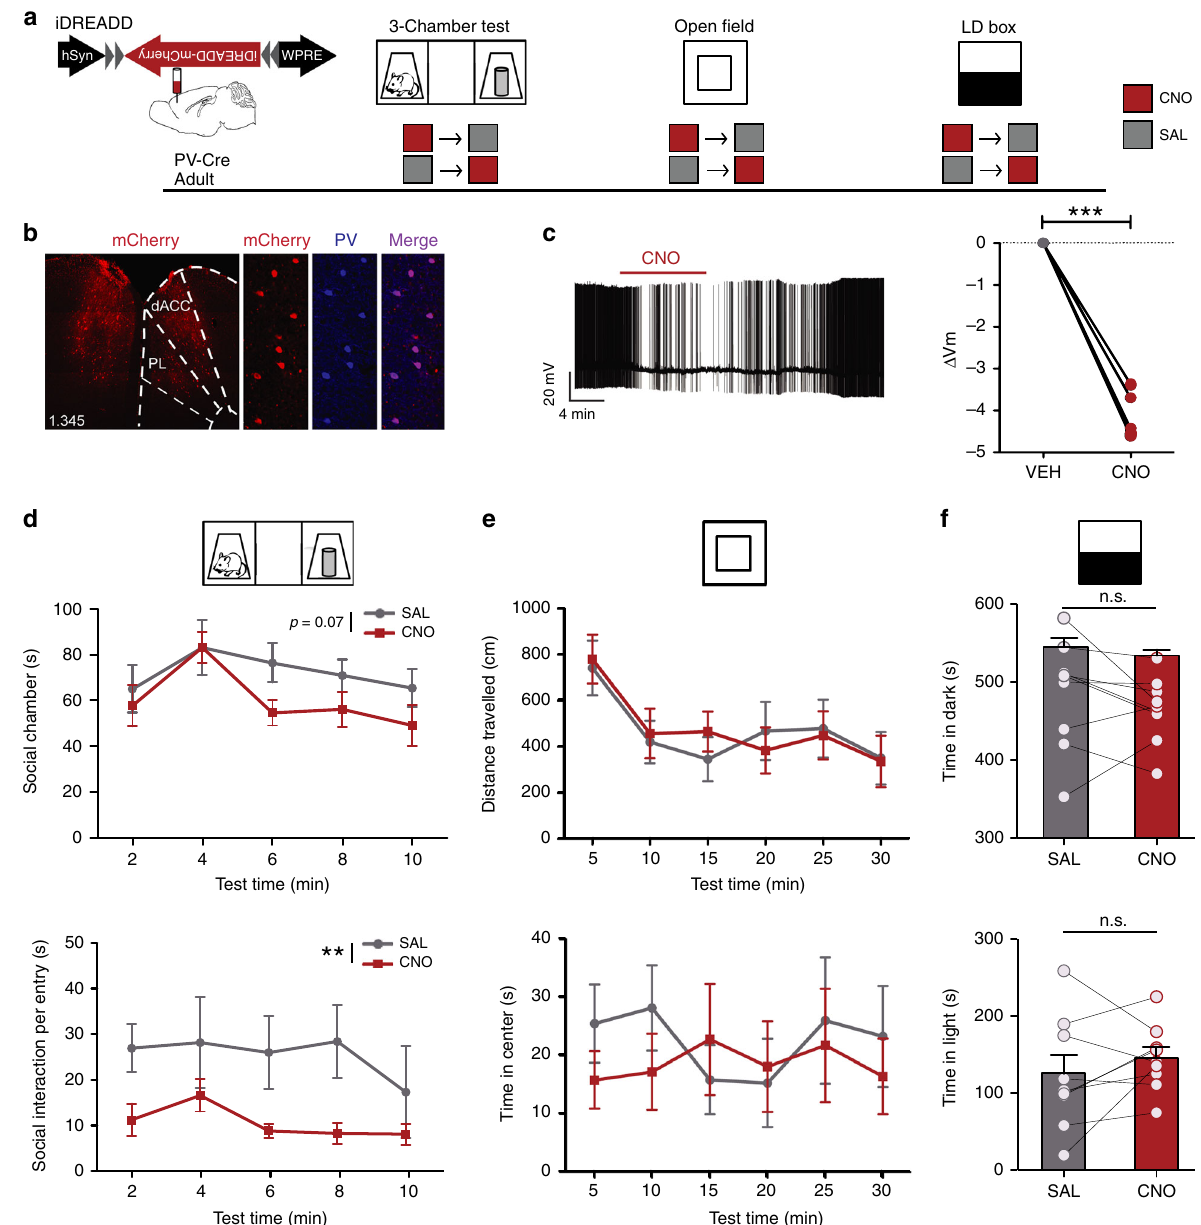
Fig. 3 Chemogenetic suppression of adult dmPFC-PVIs activity disrupts social behavior. a Timeline showing injection of Cre-dependent inhibitory DREADD (iDREADD) virus to dmPFC of adult PV-Cre mice and subsequent repeated measures behavioral design. For CNO (red square) and SAL (gray square) injections, each mouse is tested under both CNO and SAL conditions, and the order is counterbalanced for each behavior test. b Representative injection of inhibitory DREADD injected in dmPFC of PV-Cre mouse (left, scale bar = 100 μ m) and co-localization of DREADD virus expression (mCherry, red) with PV staining (blue) (right, scale bar = 50 μ m). c Validation of iDREADD in dmPFC-PVI. Left: representative trace of whole-cell recording from a PVI in adult dmPFC slice upon CNO bath application. Right: change in membrane potential from vehicle after CNO application. Repeated measures t test, t = 16.68, df = 5, *** p < 0.001, n = 6 cells from three mice. d Three-chamber tests show trending decreases in time in social chamber (top), and signi fi cant decreases in time interacting per social chamber entry (bottom) when PVIs are suppressed with CNO, compared with saline. ( n = 9 mice. Two-way repeated measures ANOVA, effect of the drug: F(1,8) = 4.39, p = 0.07 (top), F(1,8) = 14.28, p = 0.005 (bottom)). e No effect of the drug was seen on distance traveled (top) or time in the center vs. periphery (bottom) in an open- fi eld test (two-way repeated measures ANOVA, distance traveled: effect of the drug, F(1,7) = 0.01, p = 0.92, time in the center: effect of the drug, F(1,7) = 0.21, p = 0.66, n = 8 mice), or in f the light – dark (LD) box test in either time in the dark (top) or time in the light (bottom), (paired t test, time in light: t = 1.089, df = 8, p = 0.31, time in the dark: t = 1.16, df = 8, p = 0.28, n = 9 mice). All error bars re fl ect + / − SEM. See related Supplementary Figs. 5 and 6. Source data are available as a Source Data fi the fi rst active and passive bouts (Supplementary Fig. 12). JSI mice passive bout: pre vs. post, Tukey post hoc test, p < 0.001). GH, but did not show signi fi cant changes in dmPFC-PVI activity in active not jSI mice, showed a signi fi cant change from baseline during the fi rst active bout, while jSI mice showed a signi fi cant change from object exploration (Supplementary Fig. 13). We conducted an additional experiment comparing dmPFC-PVI activity prior to a baseline only after the fi rst passive bout (Fig. 4f). This is speci fi c to